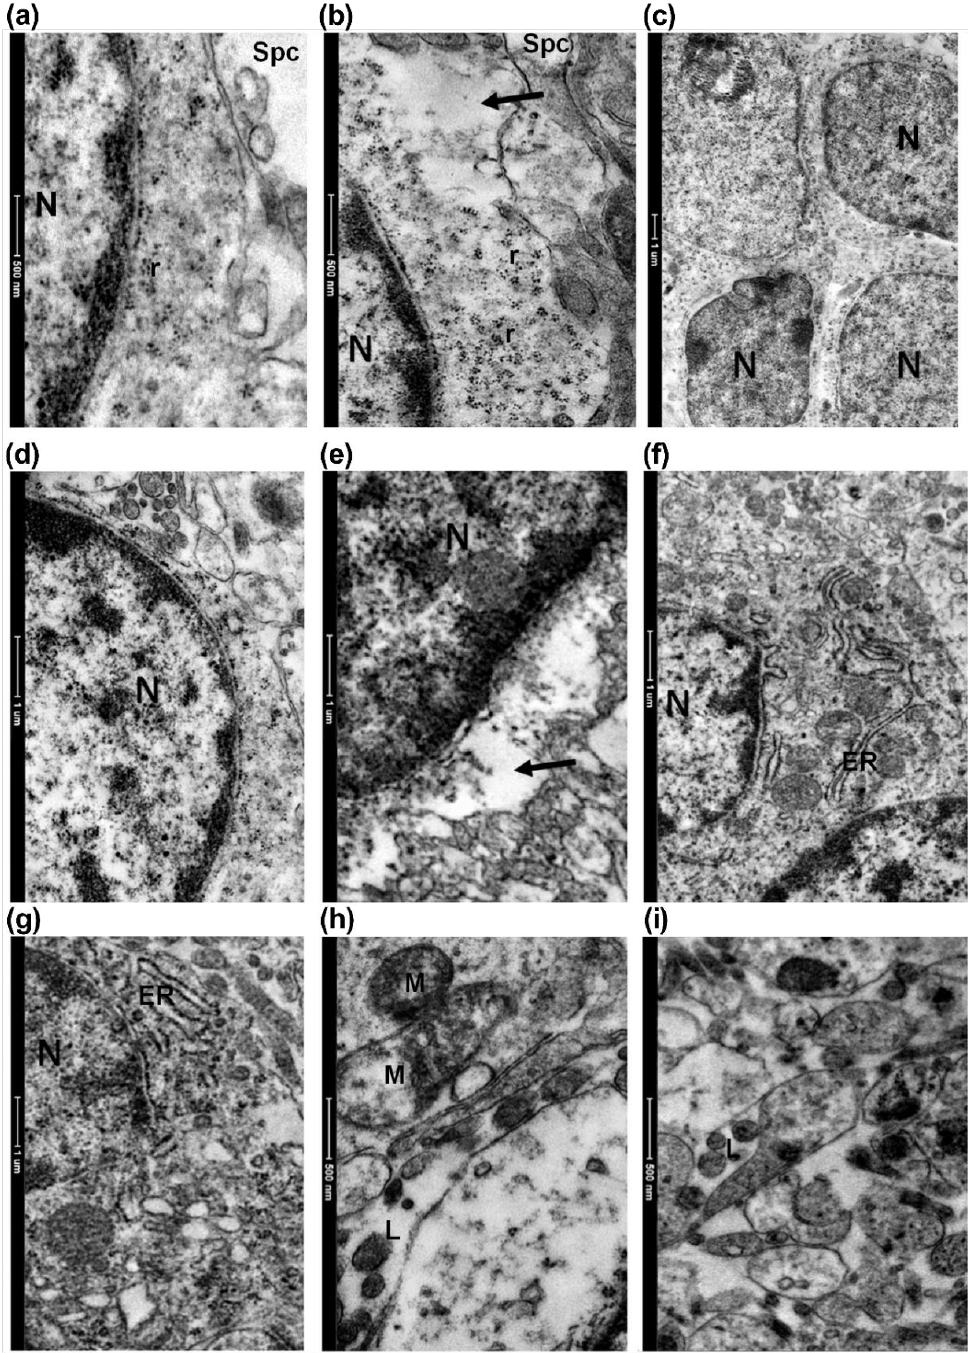
Figure 2. Ultrastructural images of the CA1 hippocampus of the pups on P5 ( a – c ) and P20 ( d - i ) in control ( a , d ) and after prenatal hyperhomocysteinemia (PHHC) ( b , c , e – i ). Electron microscopy. Spc, extracellular spaces; M, mitochondria; ER, endoplasmatic reticulum; G, Golgi apparatus; L, lysosomes; N, nucleus; r, clustered ribosomes. ( a , b ) Interneurons from the stratum oriens, ( c ) group of the glia cells from the stratum oriens, ( d – g ) projection pyramidal neurons from the stratum pyramidale, ( h , i ) fragment of the neuropil from the stratum pyramidale. In ( b , e ), cytoplasm of degenerating neurons (chromatolysis) with the area of the lysis of cell organelles (arrow) is